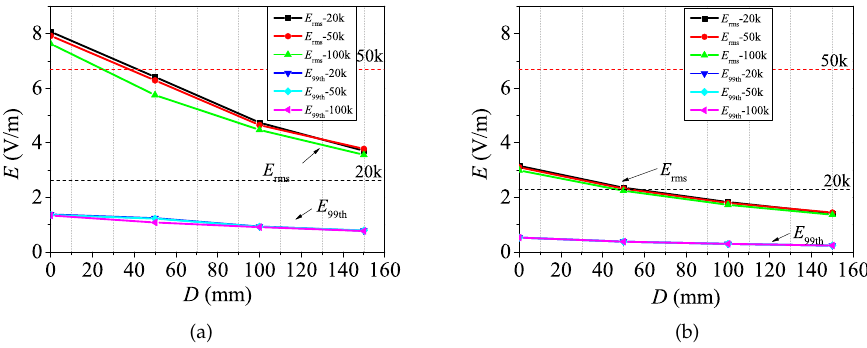
Figure 12. Curves of the ( a ) SAR-1g value and ( b ) SAR-10g value of the human body versus distance and operating frequency.